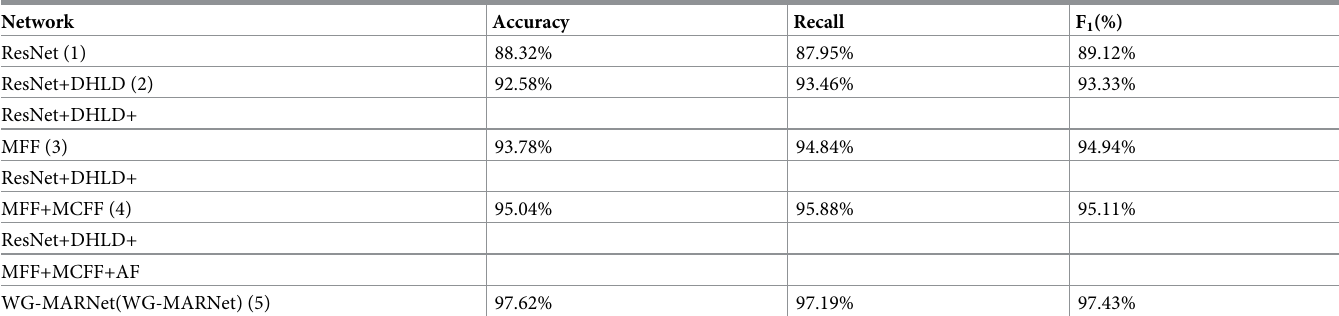
Table 6. Experimental results of each component of the